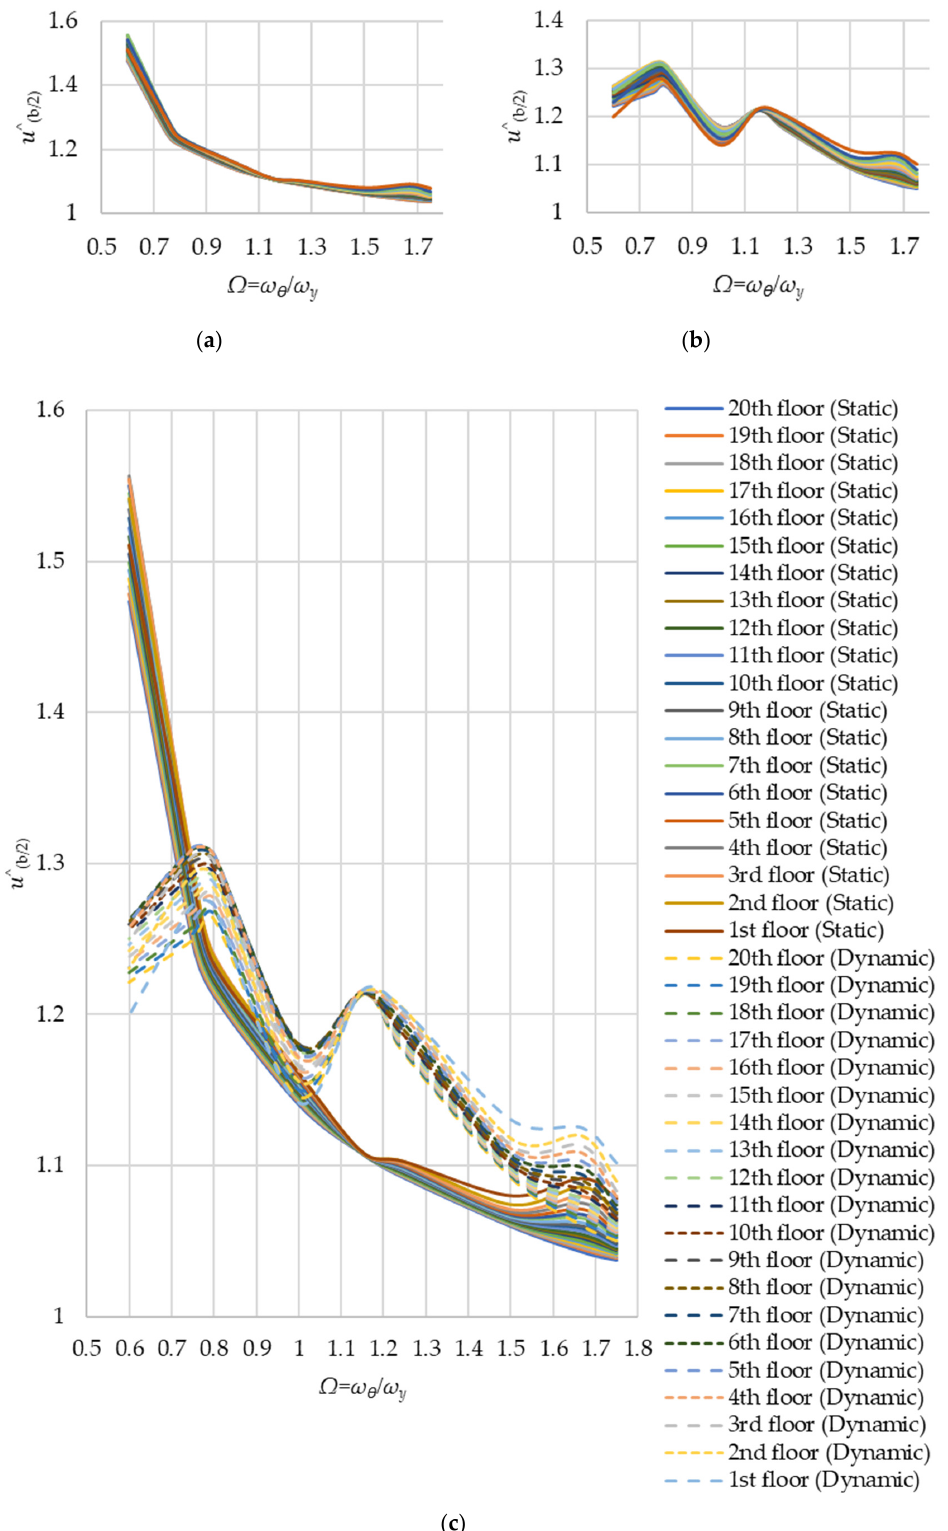
Figure 13. Normalized flexible edge displacement (with b/r = 2.45, Ty > 2sec): ( a ) Static edge displacement; ( b ) Dynamic edge displacement; ( c ) Static vs. dynamic edge displacement.